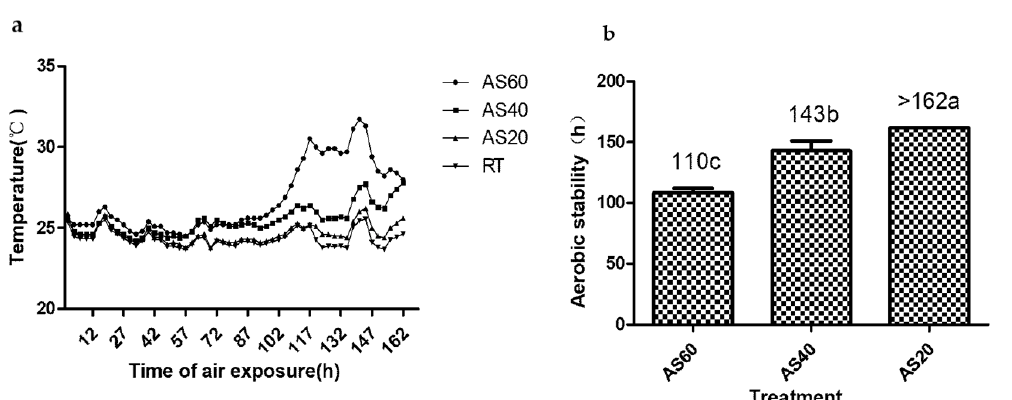
Figure 2. Dynamic changes in temperatures ( a ) and hours of aerobic stability ( b ) of the TMR silages during air exposure (bars indicate the standard errors of the means). Values with different letters show significant differences among the treatments ( p < 0.05). AS60, TMR containing 60% alfalfa silage (DM); AS40, TMR containing 40% alfalfa silage (DM); AS20, TMR containing 20% alfalfa silage (DM); RT, room